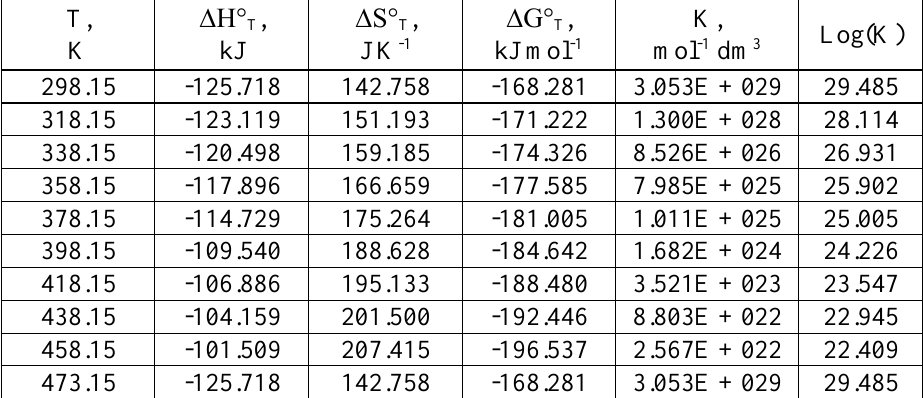
Table 2. Thermodynamic quantities for equation (2) calculated using the HSC Chemistry program